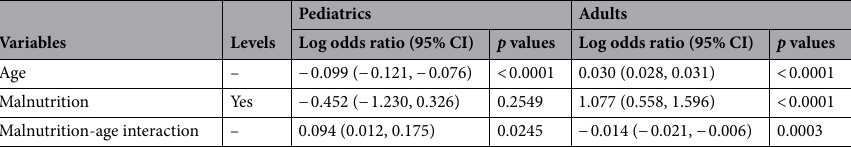
Table 2. Statistical interaction between history of malnutrition and severe COVID-19 extracted from the full multivariable model.